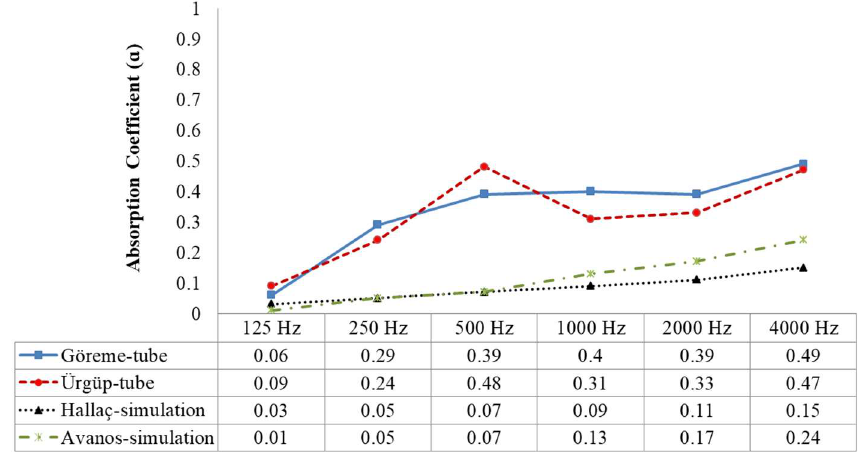
Figure 13. Absorption coefficients ( α ) of the materials over 1/1 octave bands from the Hallaç Church, Avanos Dining Hall, Göreme, and Ürgüp tuff stones. Göreme has the highest sound absorption, while the Hallaç Church seems to be the most reflective sample.